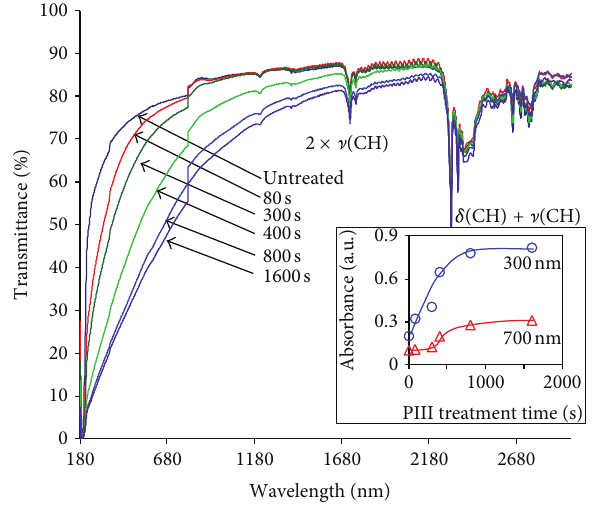
F 3: UV-Vis transmission spectra of polyethylene �lm aer PIII treatment to a range of �uences of nitrogen ions with 20keV energy. e time of PIII treatment is shown on the graph. e absorbance at short wavelength (300nm) grows quicker with PIII treatment time, than the absorbance at long wavelength